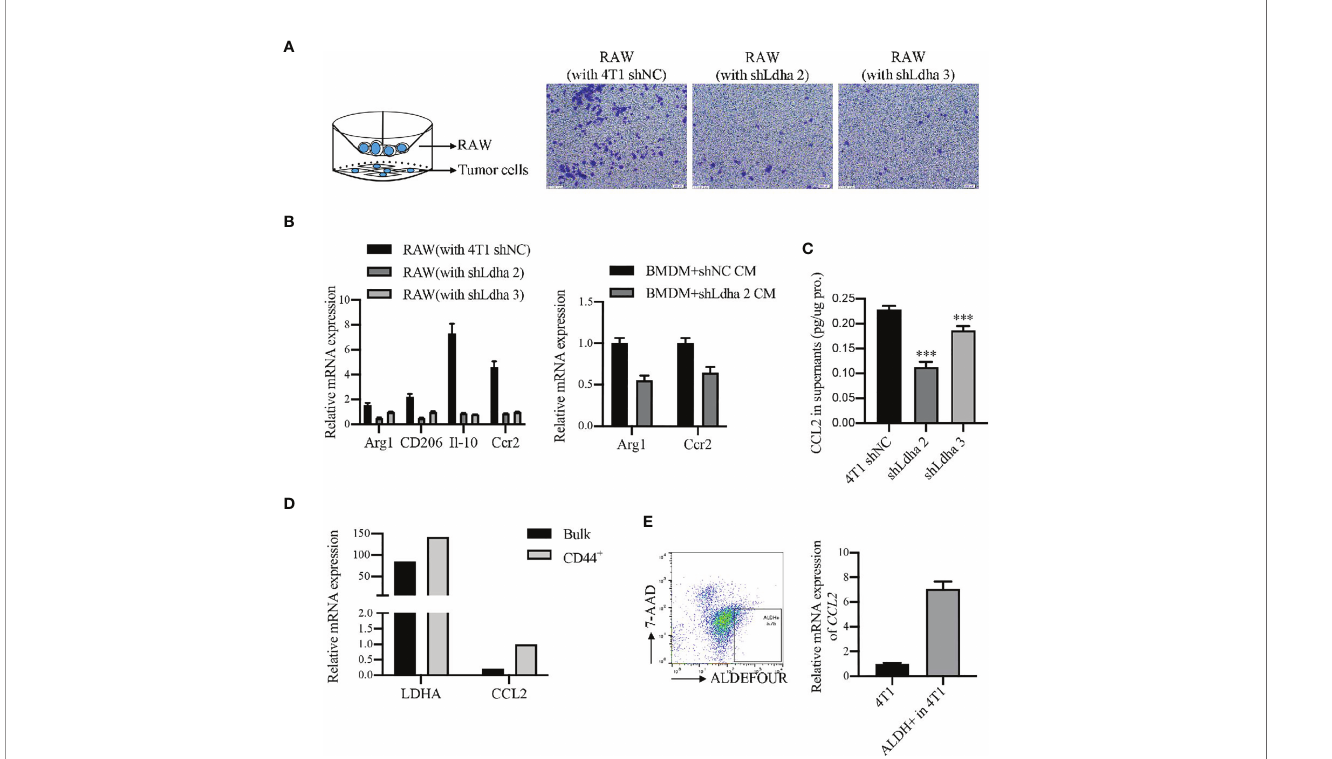
FIGURE 6 | LDHA enhanced the recruitment and M2 phenotypes of macrophages in vitro . (A) Migratory capacity of RAW264.7 cells was analyzed by Transwell assay. RAW264.7 cells were seeded in 8- m m-pore polycarbonate fi lters and 4T1-shNC or 4T1-shLdha cells were seeded in the bottom well. Representative images were visualized by microscope (right) and percentage of migrating cells was calculated by use of ImageJ. Scale bar, 200 m m (insets). (B) Relative mRNA level of M2 markers in RAW 264.7 or BMDM cultured with conditional medium from 4T1-shNC or 4T1-shLdha cancer cells were detected by RT-qPCR. (C) Ccl2 level in the cultural supernatant from 4T1-shNC or 4T1-shLdha cells was detected by ELISA. Results were normalized by protein content in cells. (D) Relative mRNA level of LDHA and CCL2 in M-BCSCs or bulk cells were analyzed according to GSE115302 data set. (E) The mRNA level of Ccl2 was measured by RT-qPCR in ALDH + or bulk 4T1 cells. ALDH + 7-AAD - cells were sorted out by fl ow cytometry. Error bars mean ± SD from three independent experiments. *** P < 0.001.